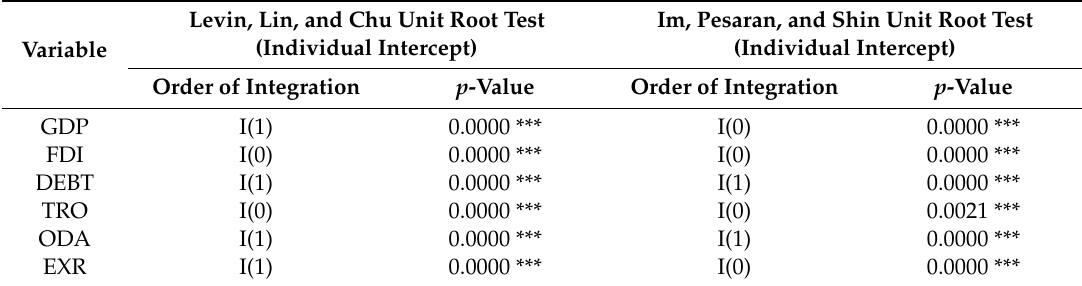
Table 2. LLC and IPS panel unit root tests for lower-middle income.